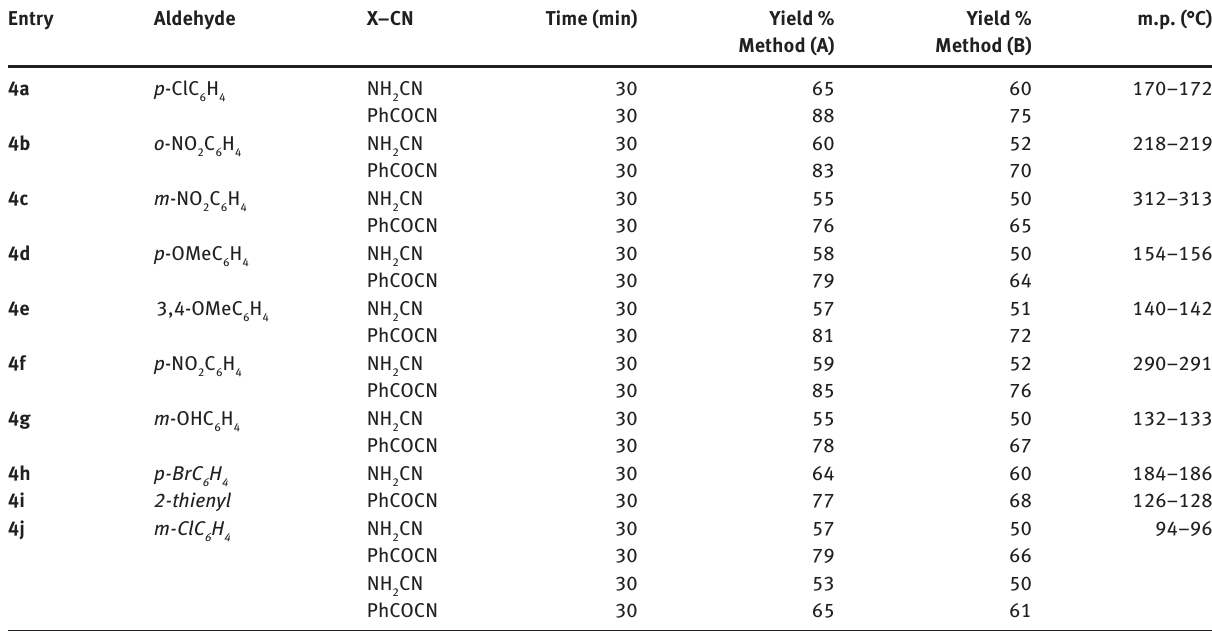
Table 1: List of [1,2-a]pyridine-3-ylamine derivatives synthesized via microwave